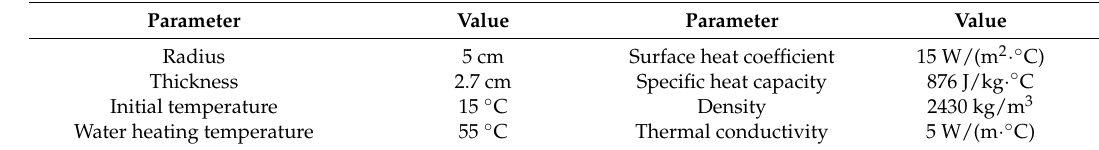
Table 1. The performance parameters of sample X1.